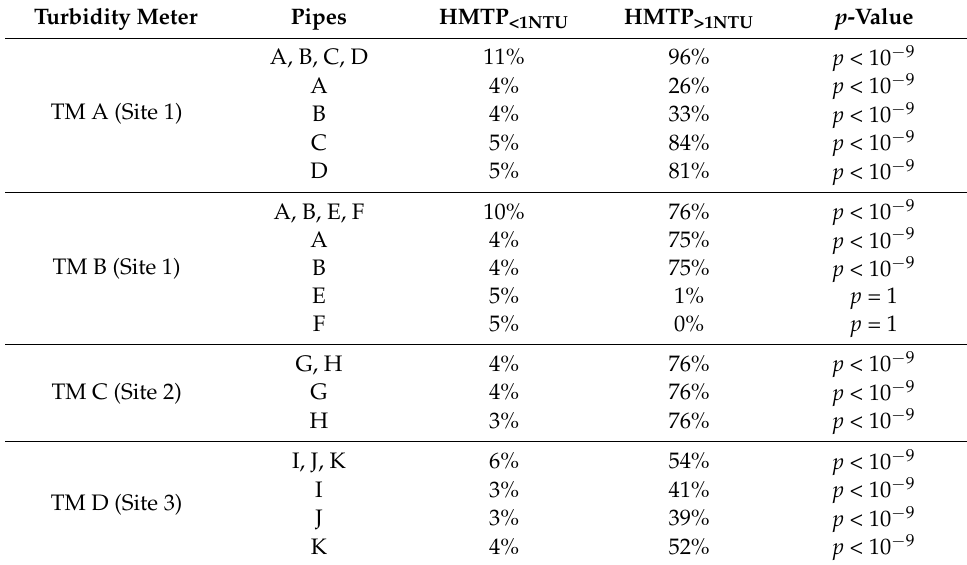
Table 4. Hydraulically Mobilised Turbidity Percentage (HMTP) results with the x parameter set to 30 days and the y parameter set to 1